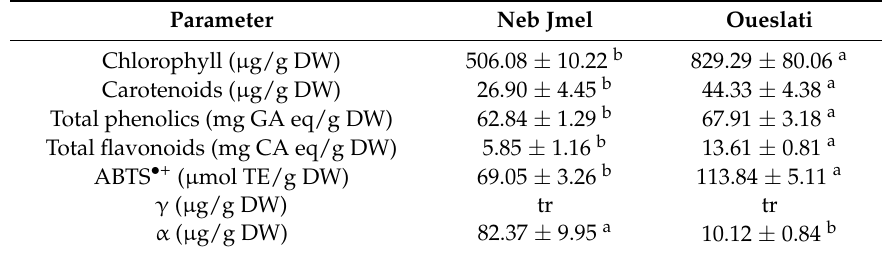
Table 2. Chlorophyll, carotenoid and total phenols, flavonoids and tocopherol ( α and γ ) contents,